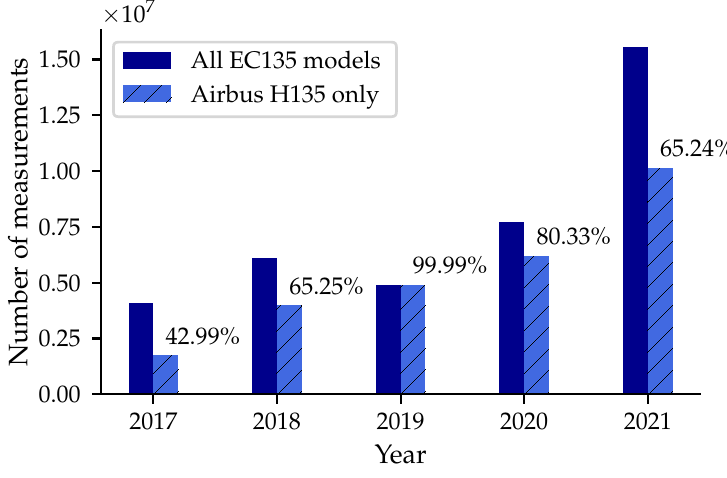
Figure 8. Number of measurements per year and share of the helicopter model Airbus H135.